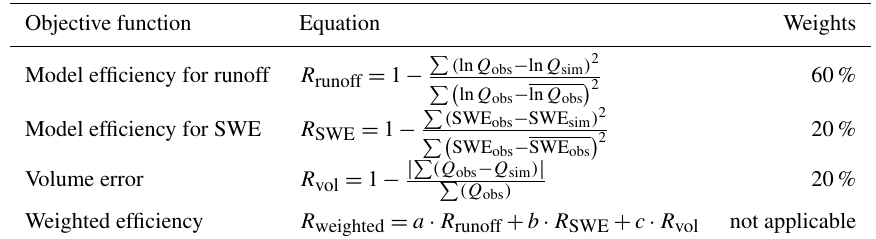
Table 2. Objective functions used for model calibration and